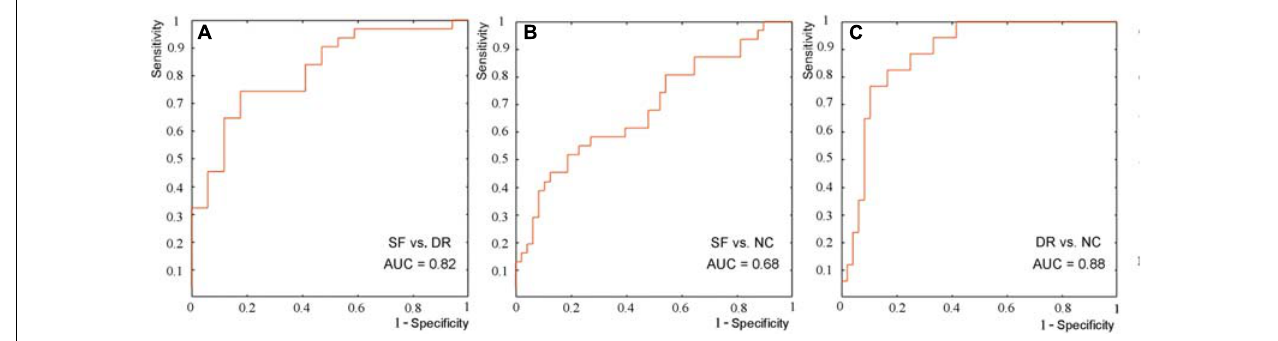
FIGURE 5 | ROC curve of the classification between seizure-free and drug-resistant patients (A) , between seizure-free patients and NCs (B) , and between drug-resistant patients and NCs (C) .